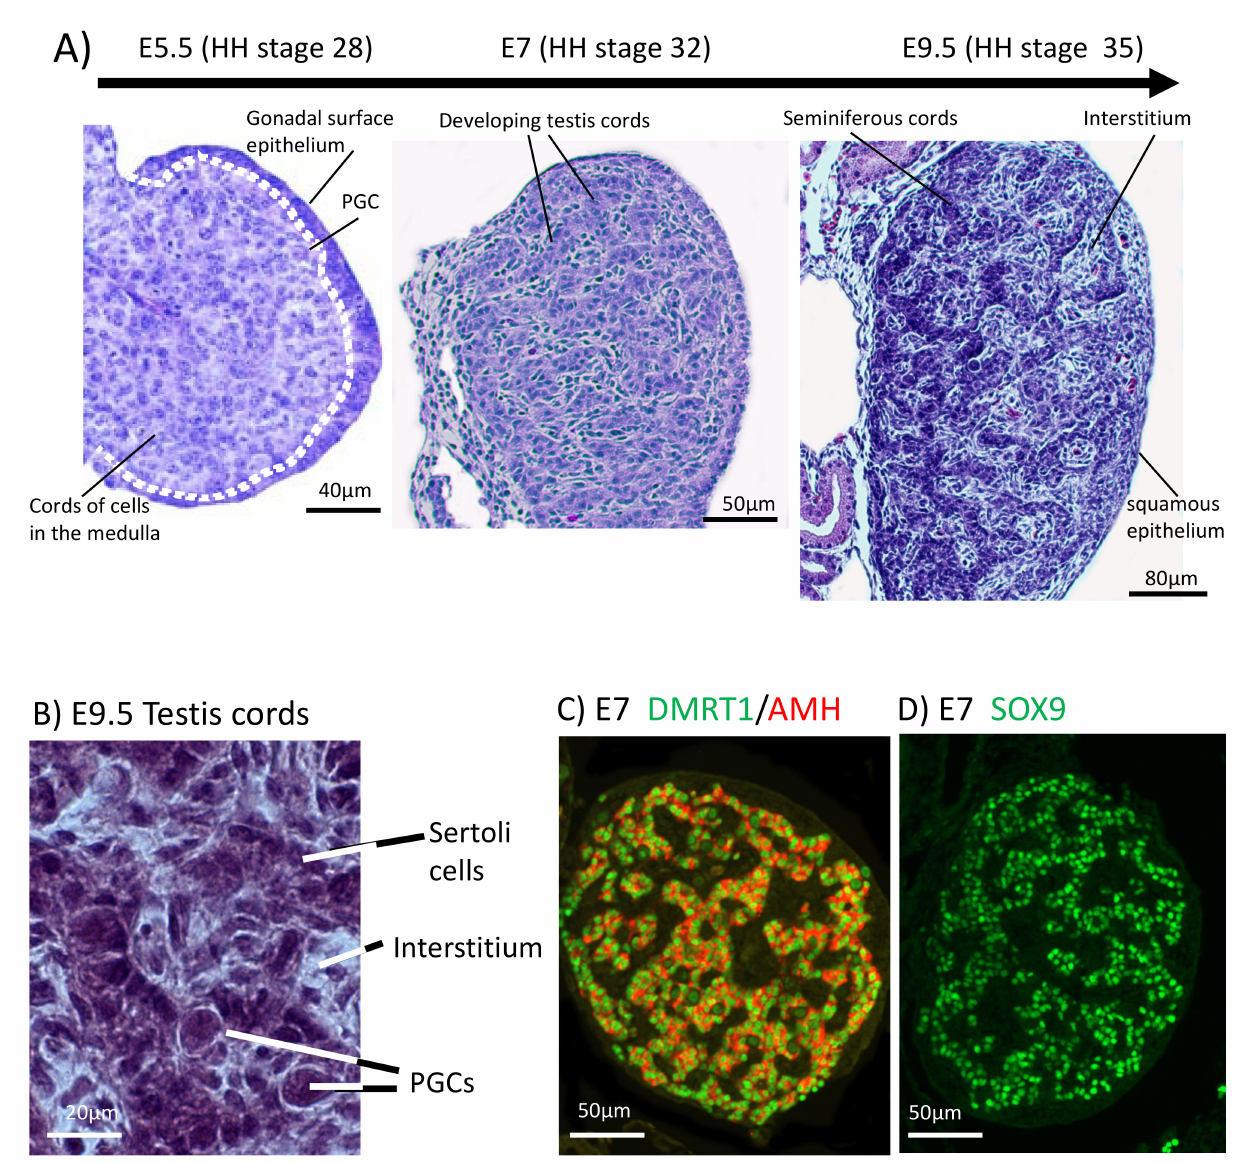
Figure 2. Testis development in the chicken embryo. ( A ) Histology of early testis differentiation, from E5.5 to E9.5. At E5.5, the gonad is morphologically undifferentiated, comprising outer epithelial cell layer and cords of cells in a dense underlying medulla. Dotted line demarcates the surface epithelium. Between E6.0 (stage 31) and E7.0 (stage 32), pre-Sertoli cells differentiate in the medulla, generating testis cords. By E9.5 (stage 35), Sertoli cells and primordial germ cells (PGCs) are apparent in testis (seminiferous) cords. The outer epithelium has become flattened, forming a squamous cell layer. ( B ) High magnification view of E9.5 (stage 35) testis cords, showing Sertoli cells, PGCs and surrounding mesenchymal cells in the interstitium. ( C ) Expression of the Sertoli cell markers, DMRT1 (green) and AMH (red) in the developing testis cords at E7 (stage 32). ( D ) Expression of the Sertoli cell marker, SOX9 (green) in the nuclei of Sertoli cells at E7 (stage